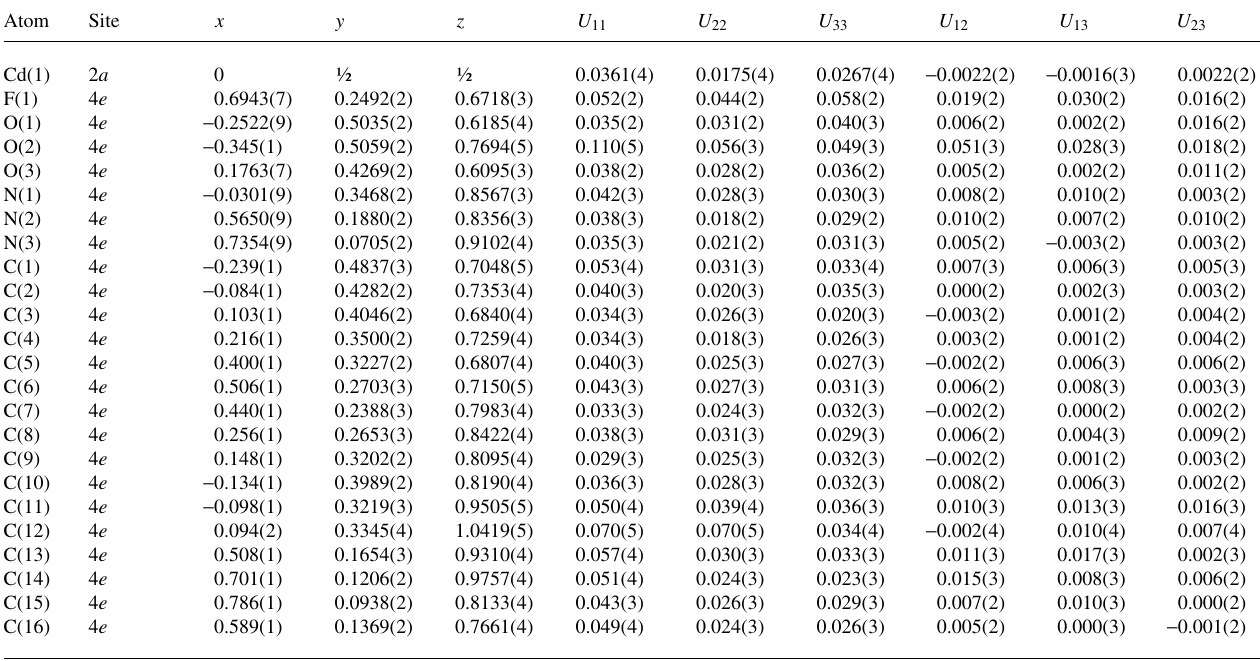
Table 3. Atomic coordinates and displacement parameters (in Å 2 )